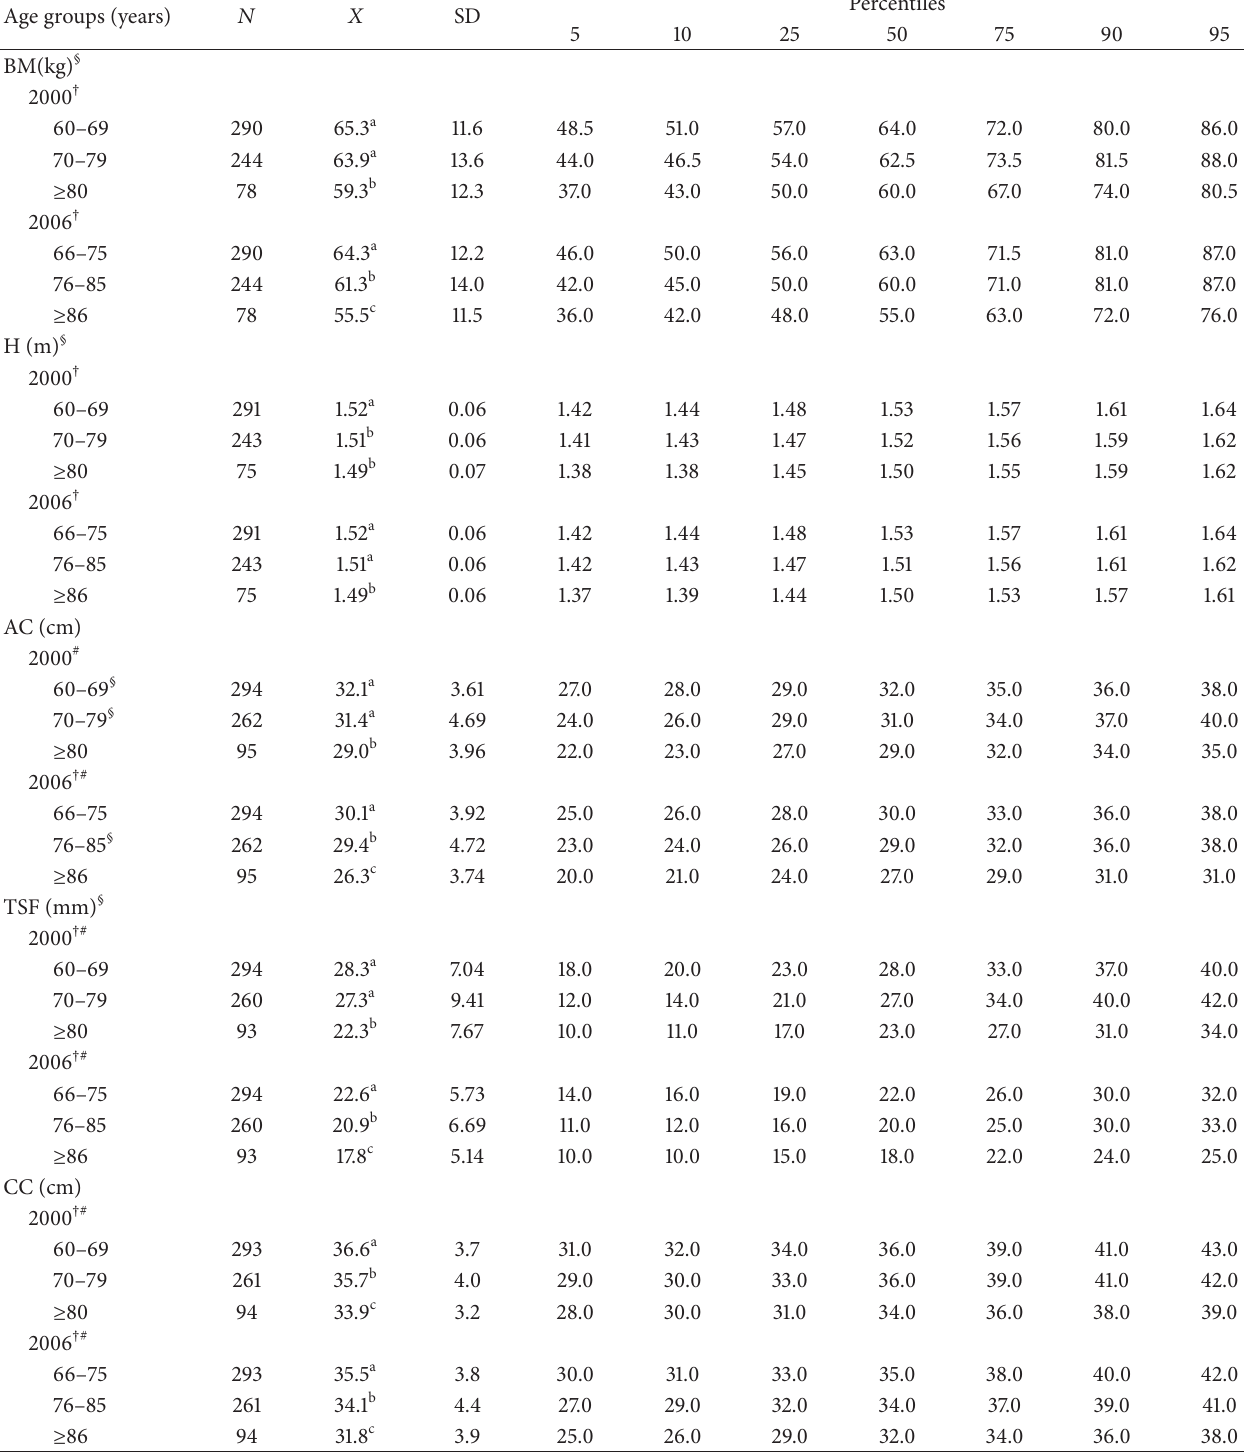
Table 1: Percentile distribution of anthropometric values of women by age group (SABE Survey, S˜ao Paulo, Brazil,